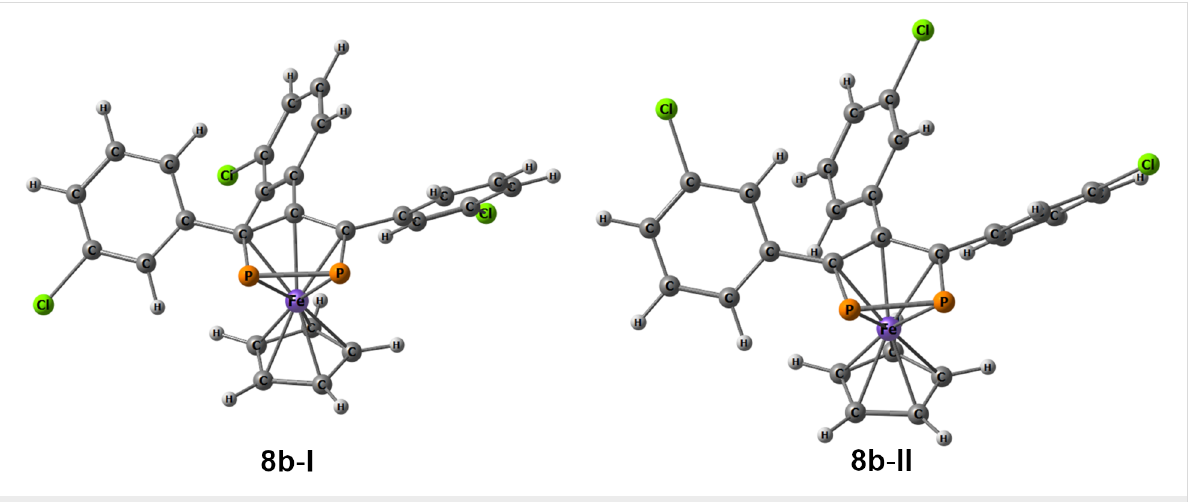
Figure 2: Considered conformations of 8b-I and 8b-II